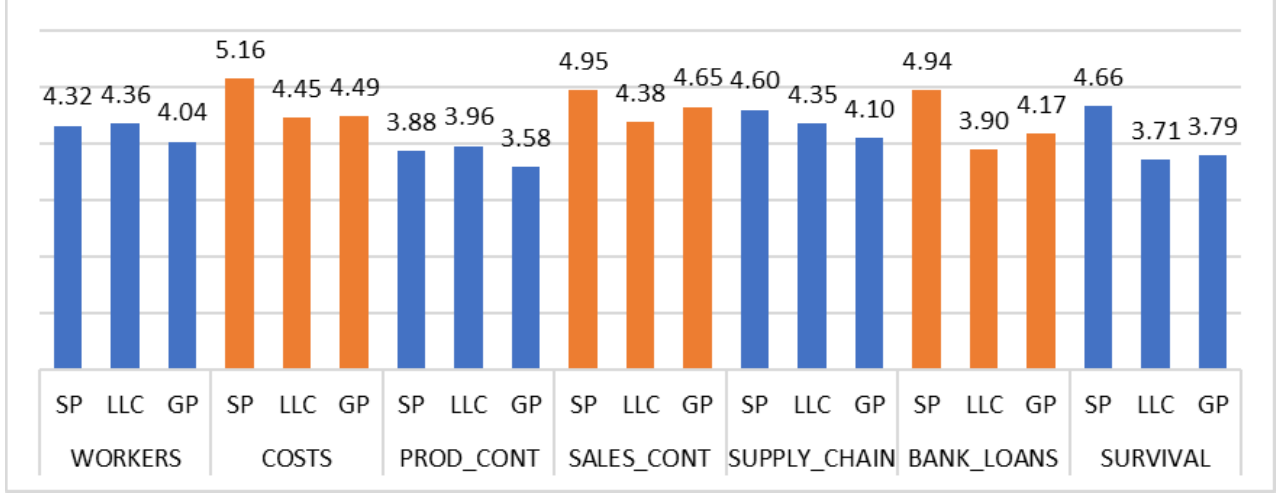
Figure 1. Comparison of means of the COVID-19 impacts by the legal form of the business. Table 3. Contingencies between the legal form of the business and the COVID-19 interruptions (Chi-squared test).